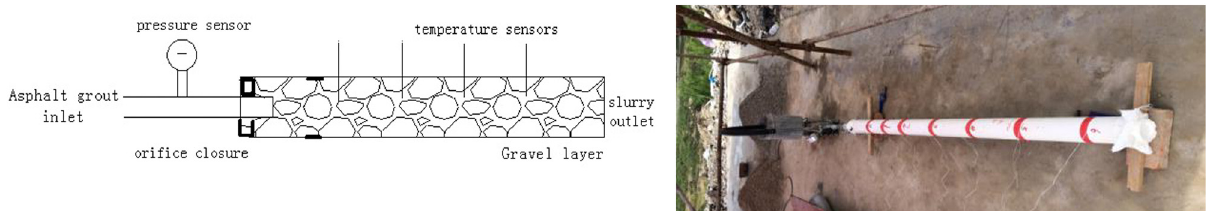
Figure 7: Design and image of the 1D experiment